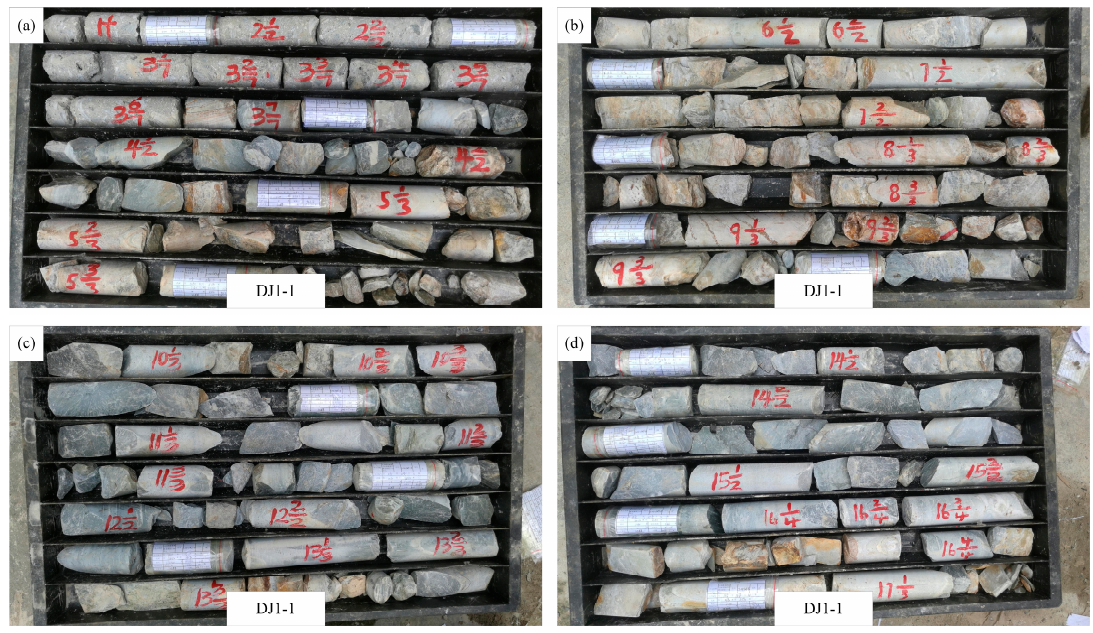
Figure 8. The results of core drilling of the verification hole DJ1-1: ( a ) The core specimen image of DJ1-1 from depths of 2.3–3.9 m; ( b ) the core specimen image of DJ1-1 from depths of 10.4–11.7 m; ( c ) the core specimen image of DJ1-1 from depths of 13.6–15.5 m; and ( d ) the core specimen image of DJ1-1 from depths of 21.9–23.9 m.